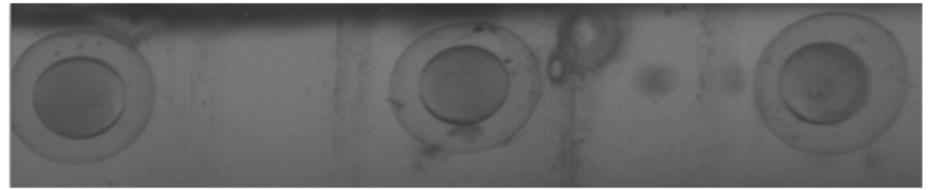
Figure 13. Zebrafish embryos in cell-holding device.